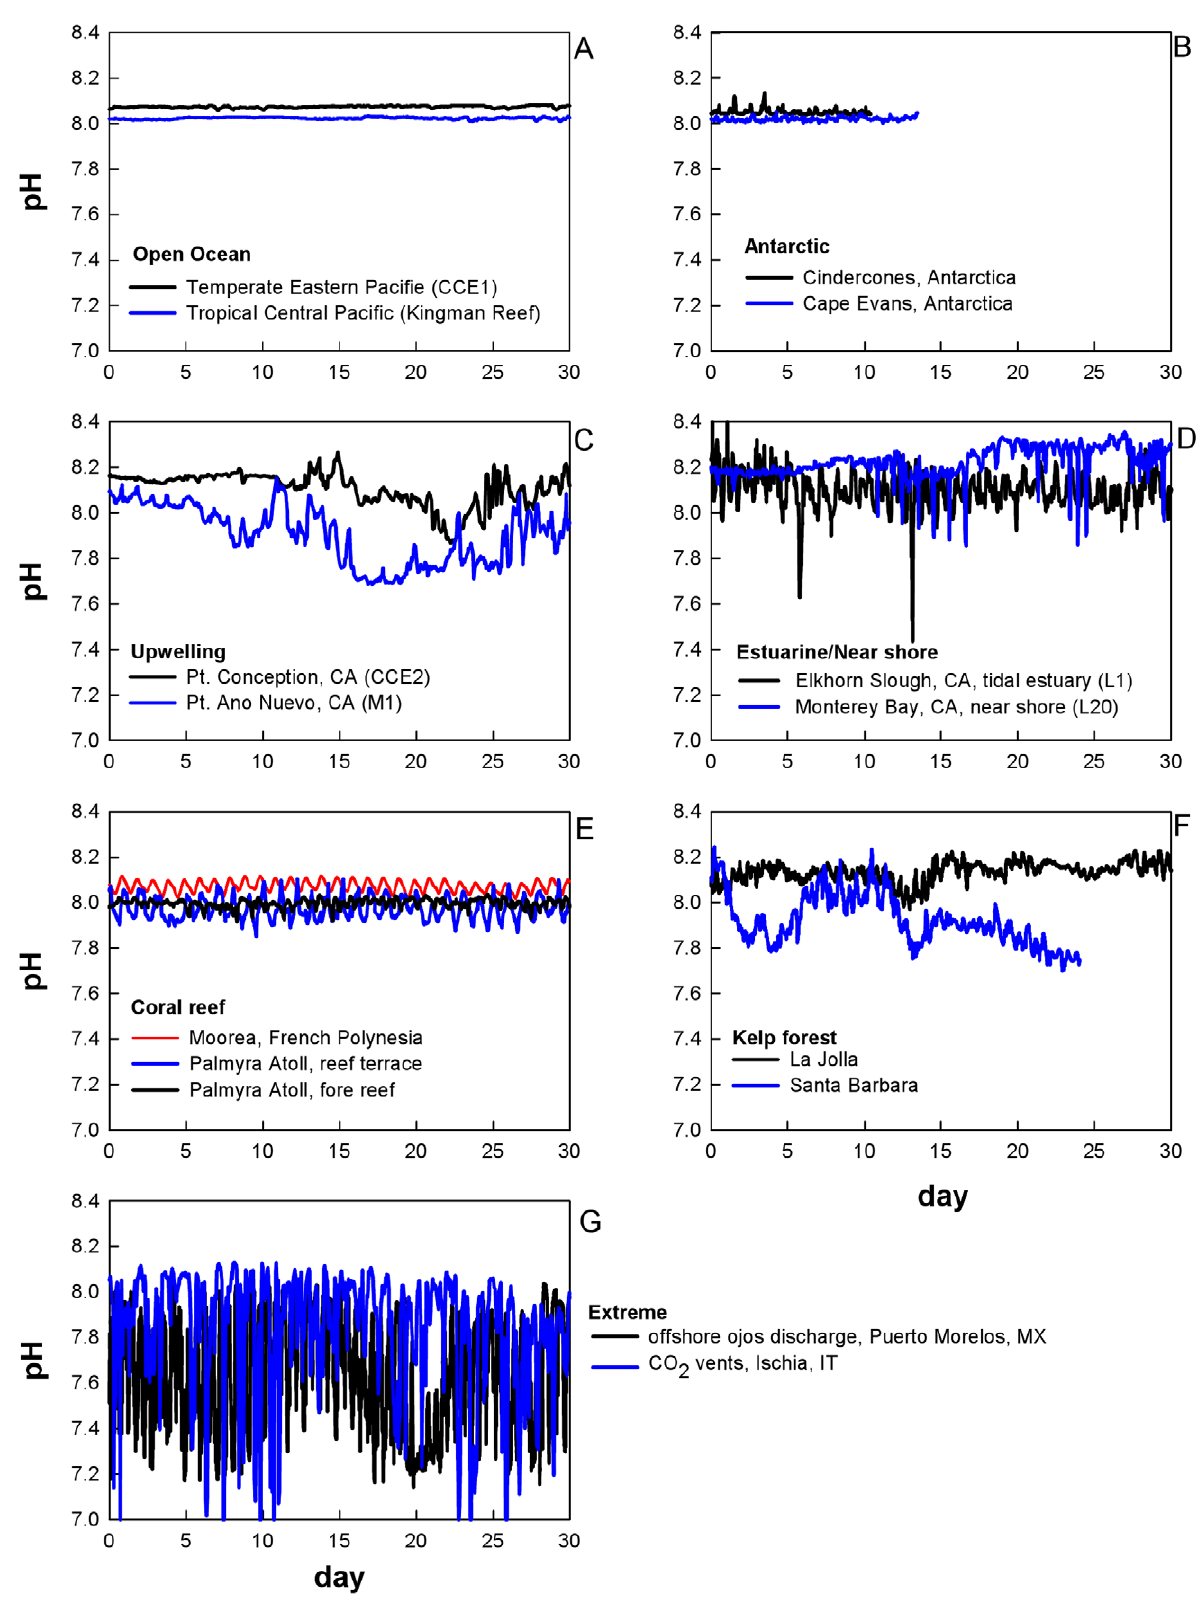
Figure 2. pH dynamics at 15 locations worldwide in 0–15 m water depth. All panels are plotted on the same vertical range of pH (total hydrogen ion scale). The ordinate axis was arbitrarily selected to encompass a 30-day period during each sensor deployment representative of each site during the deployment season. See Table 1 for details regarding sensor deployment. doi:10.1371/journal.pone.0028983.g002 PLoS ONE |